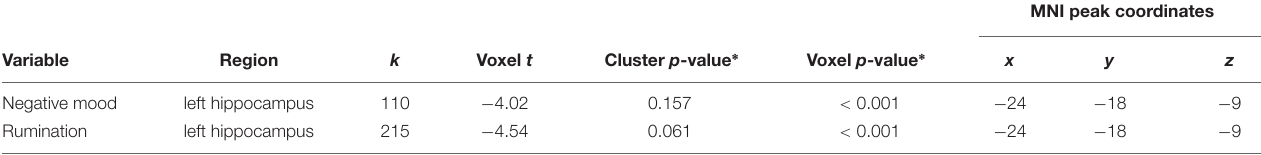
TABLE 2 | Exploratory gray matter findings of whole-brain voxel-based morphometry analyses and their associations with daily mood states.